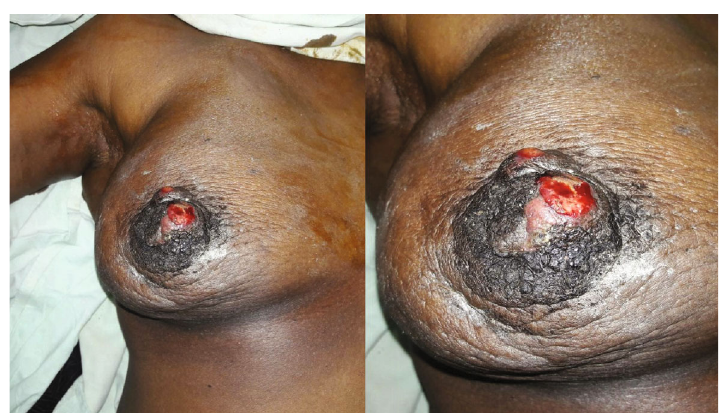
Figure 1: Fungating tumour with active bleeding from the